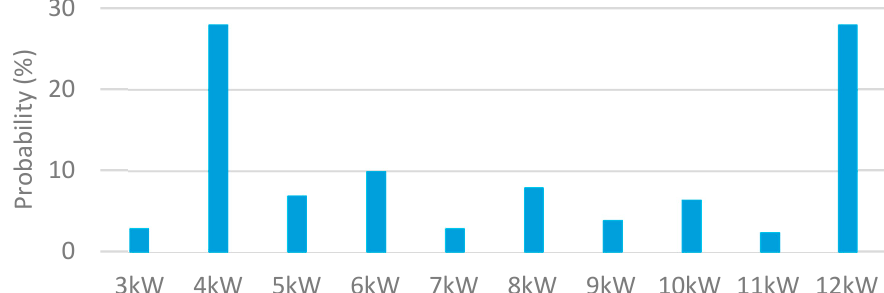
were captured at the Universiti Teknikal Malaysia Melaka (UTeM). Figure 5. PV generation profiles and aggregated PV generation profile for the 365 days in 2016 that